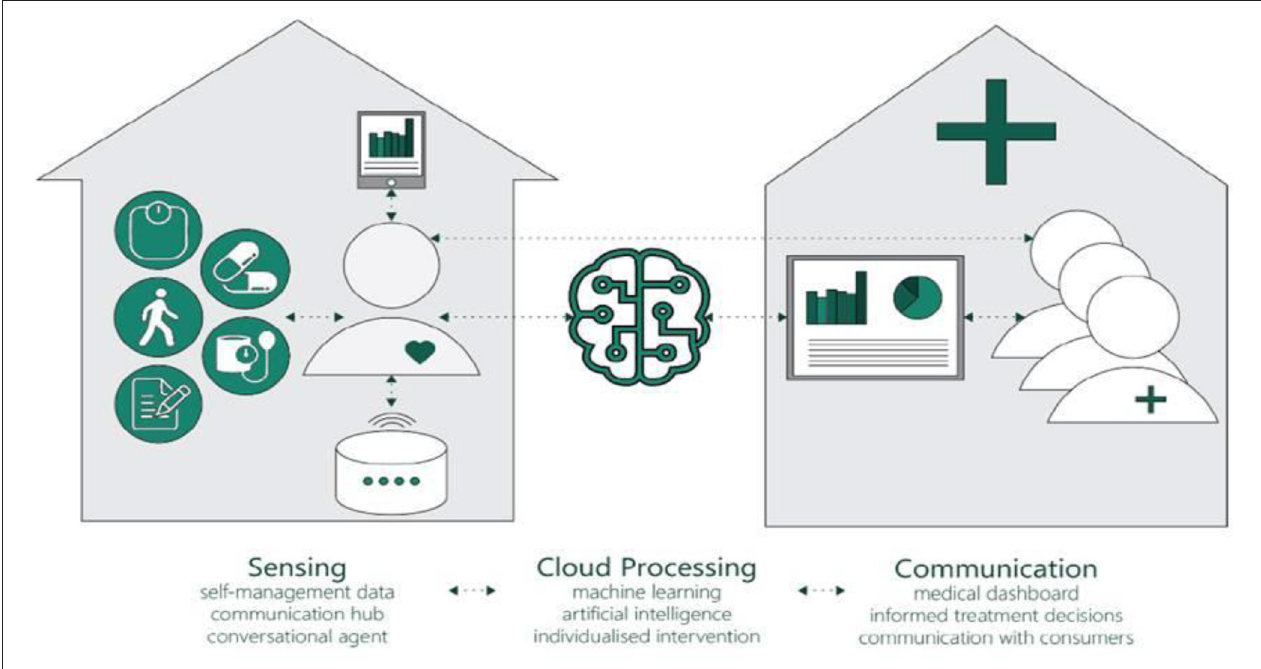
FIGURE 1 | A conceptual framework of Smart Home for people with heart failure.